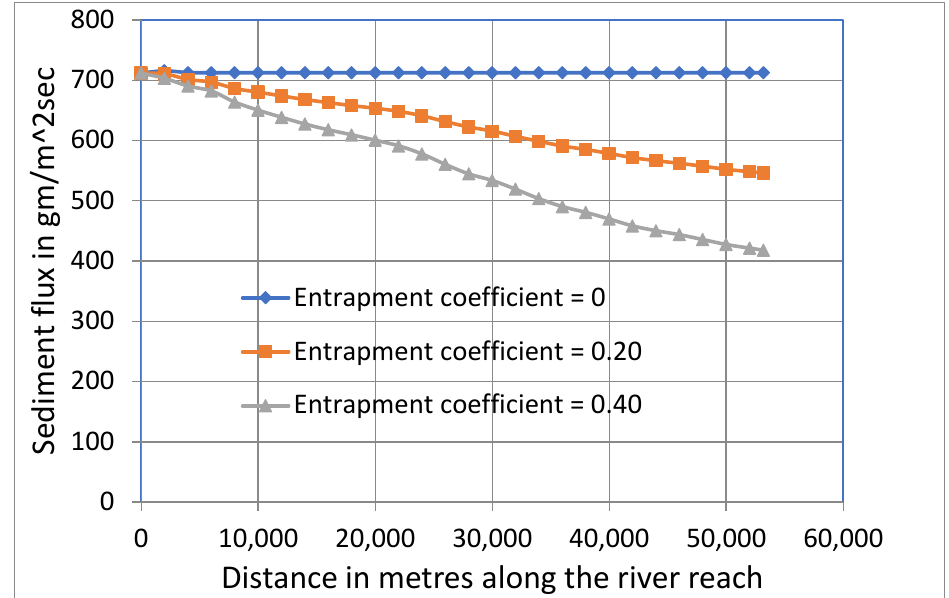
Figure 12. Fine sediment transport rate computed by RIVFLOC for the full Crowsnest River reach.